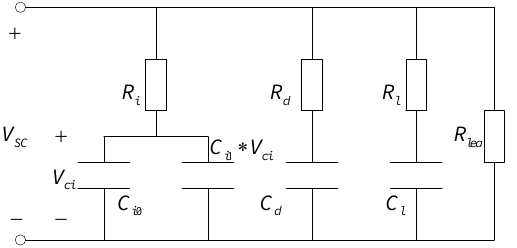
Figure 3. Equivalent model circuit for the supercapacitor.